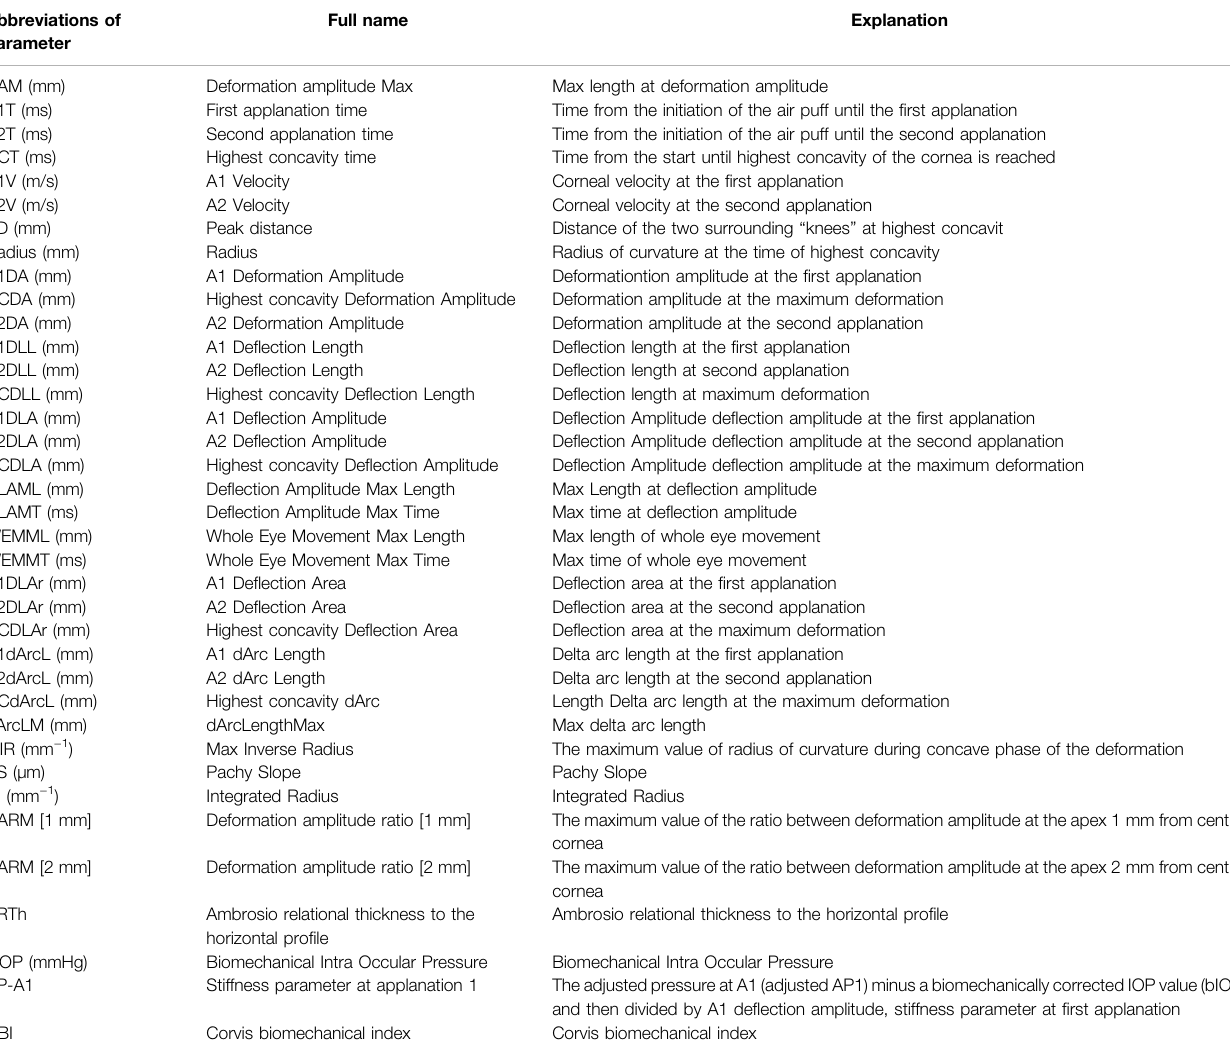
TABLE 1 | Abbreviations and explanations of parameters measured by Corvis ST. Abbreviations of